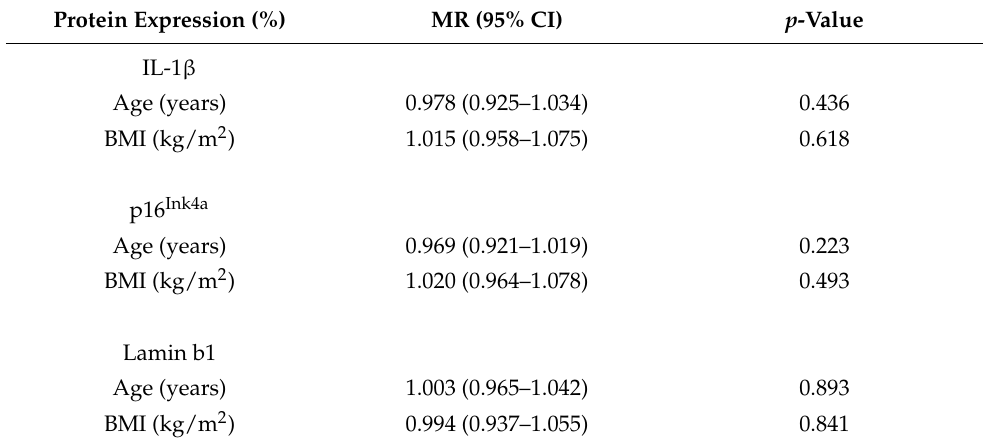
Table 1. Correlation between age and BMI with protein expression in tissue samples.